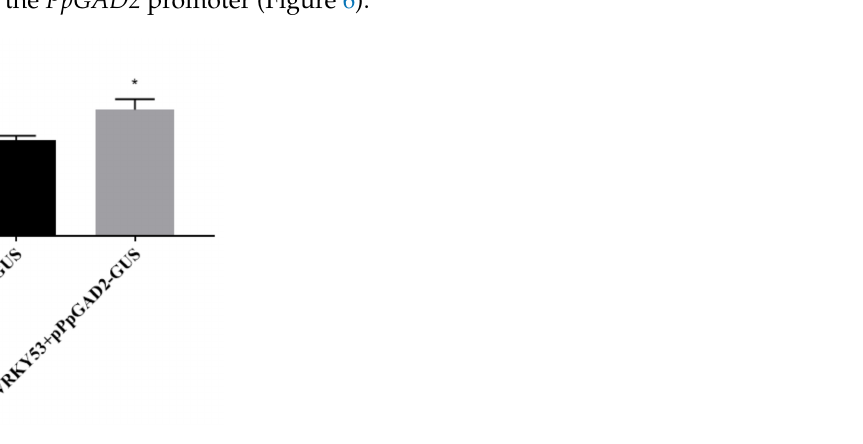
Figure 6. The change of PpGAD2 promoter-gus activity combine with PpWRKY53 . The asterisk on the bars represent standard errors from three independent replicates. * p <